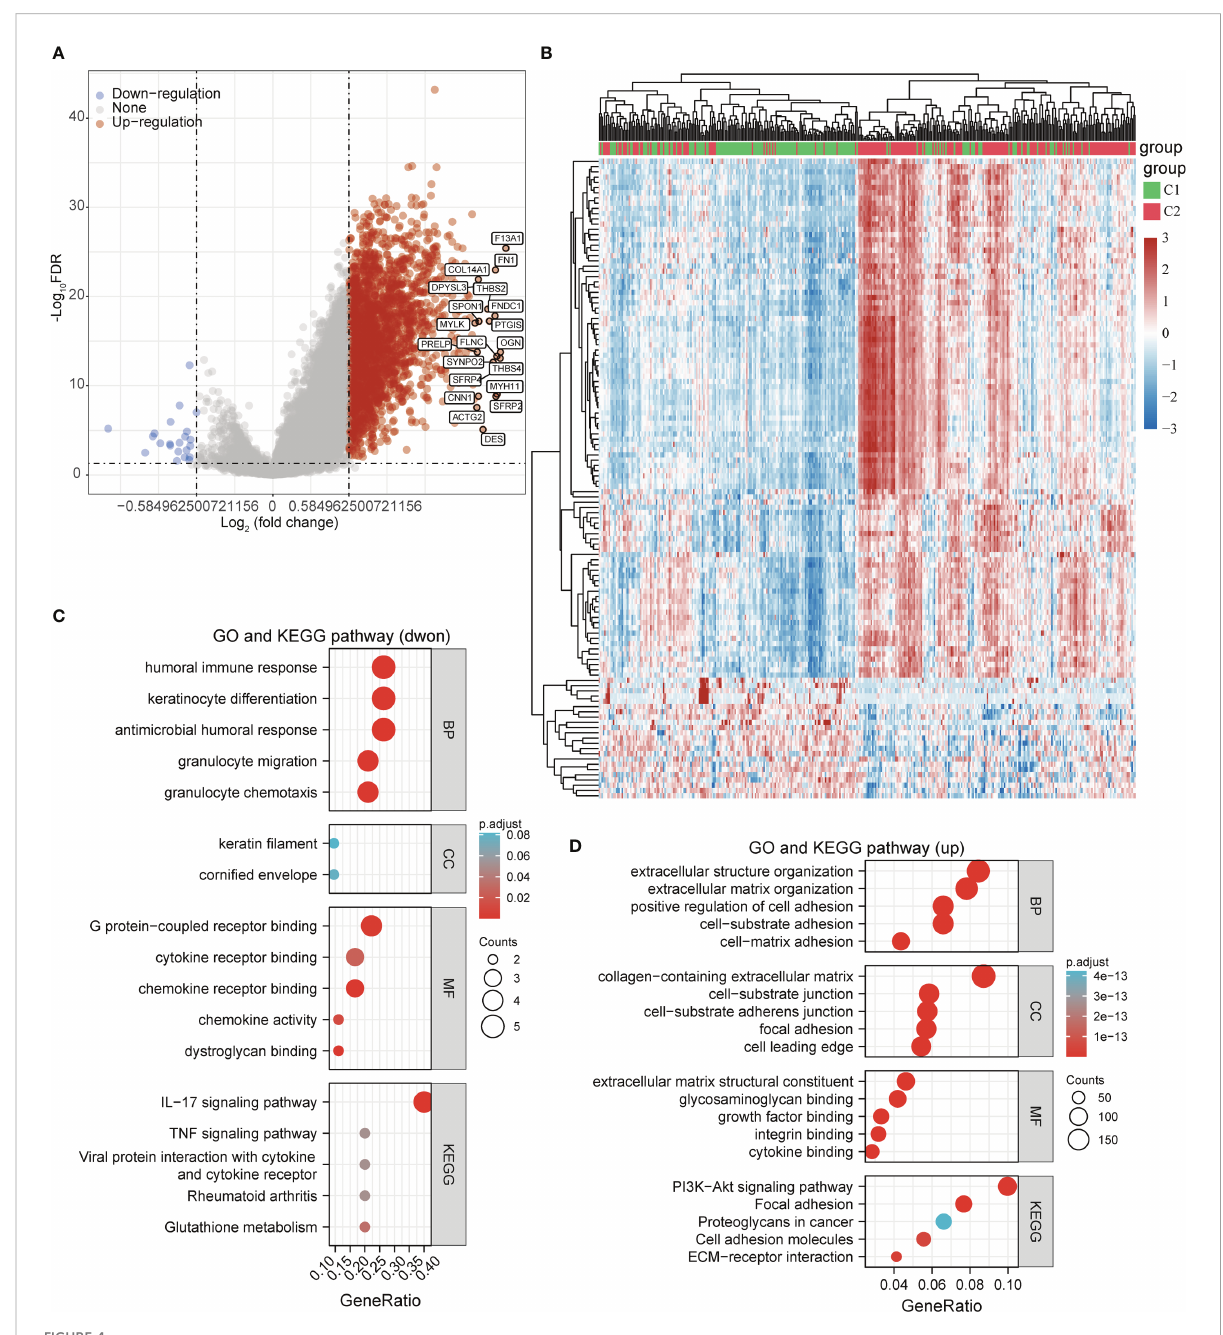
FIGURE 4 Functional enrichment analysis of DEGs between the two subgroups. (A, B) Volcano and heat maps of differentially expressed genes between the two subgroups in the TCGA-STAD cohort. (C) GO and KEGG pathway enrichment analysis of differentially expressed genes that were dwon- regulated. (D) GO and KEGG pathway enrichment analysis of differentially expressed genes that were